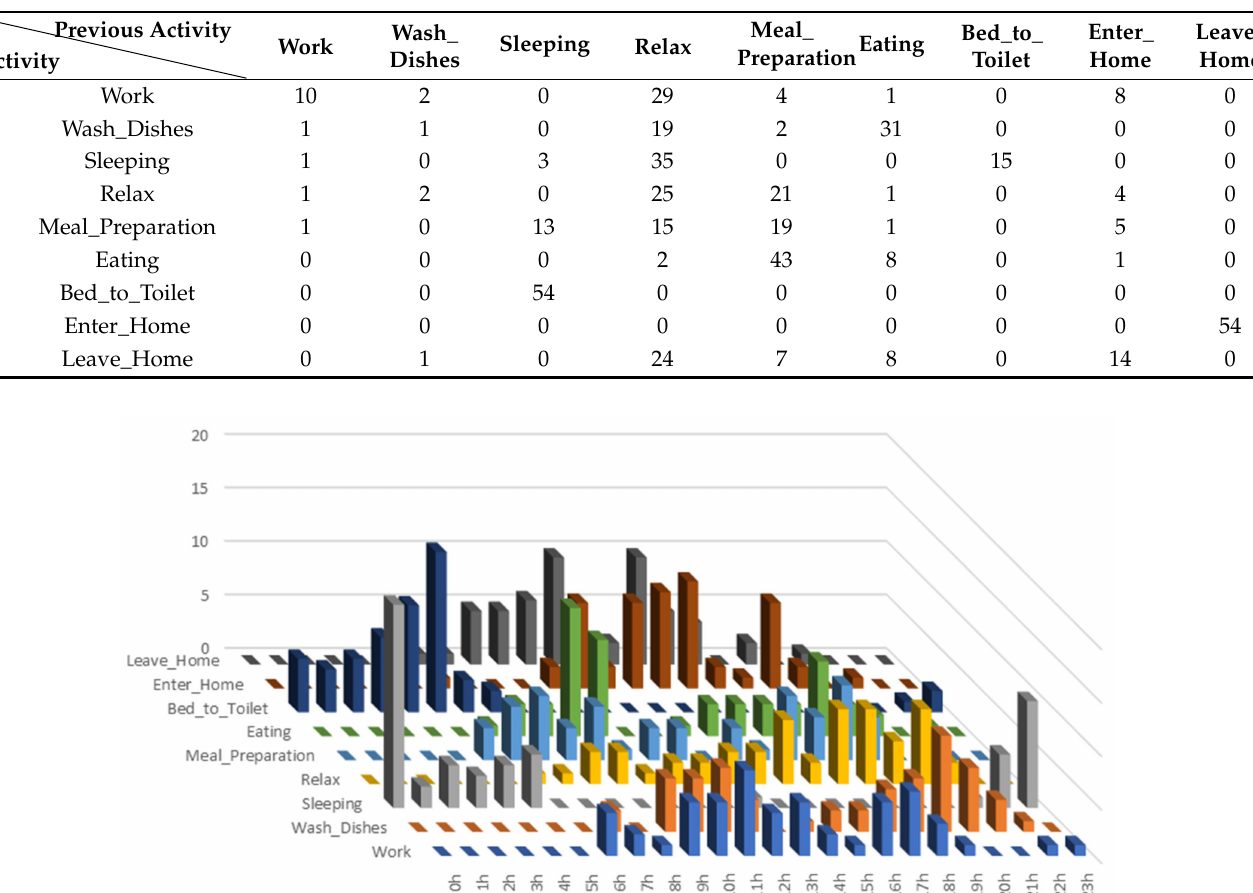
Table 1. Number of previous activity instances for activities selected in train and test sets.